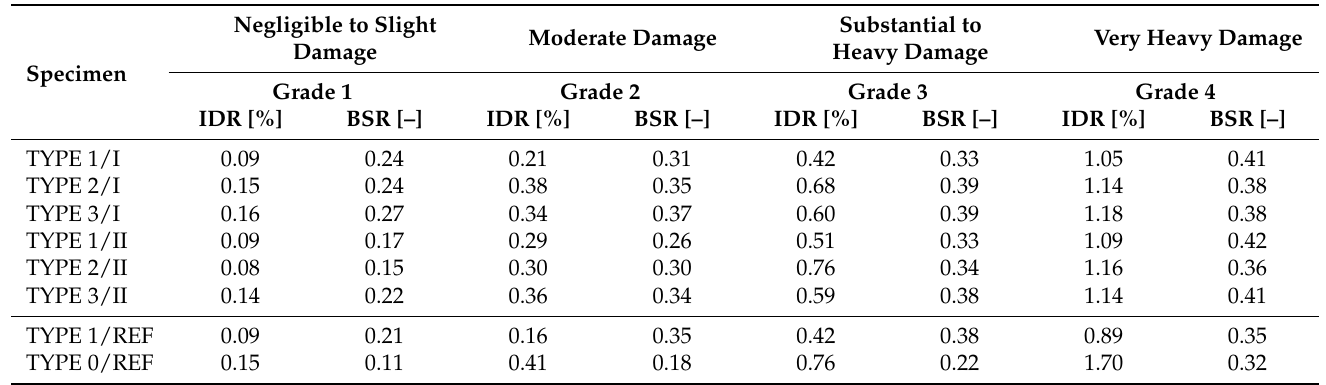
Table 2. Observed performance and damage grades of the tested